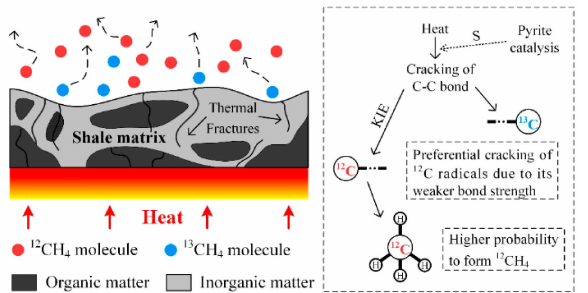
Figure 7. Carbon isotopic fractionation during shale